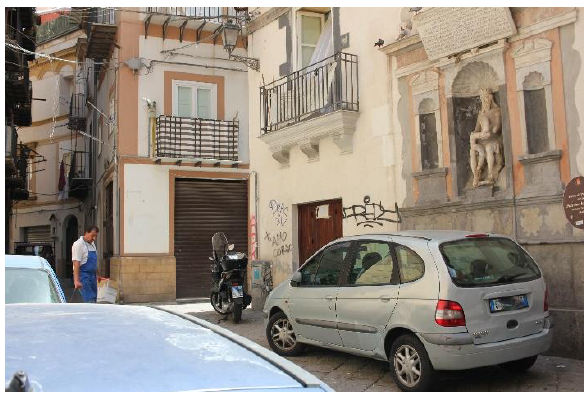
Figure 4. Piazza Garraffo, the square nowadays.